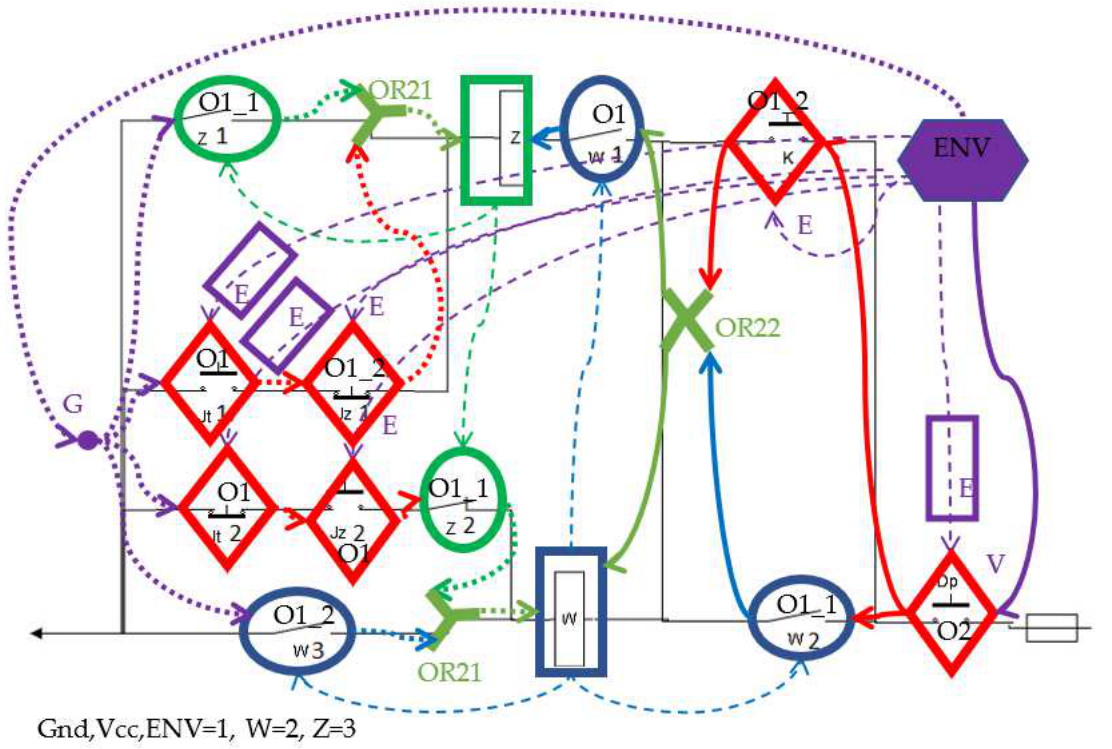
Figure 5. Identification of logical elements on the schematic diagram of the line block, and marking their types.